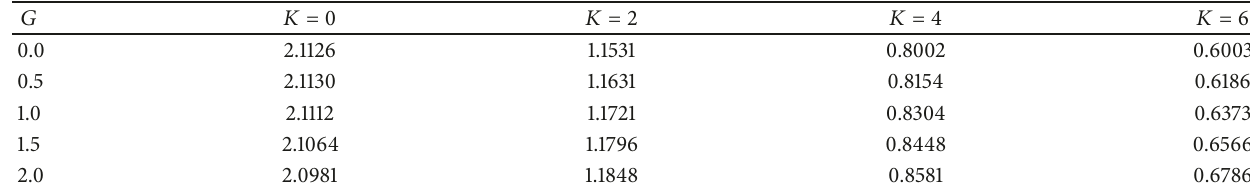
Table 2: |Ψ max min | against internal heating parameter with different 𝐾 for discontinuous case at 𝜙 = 0.1